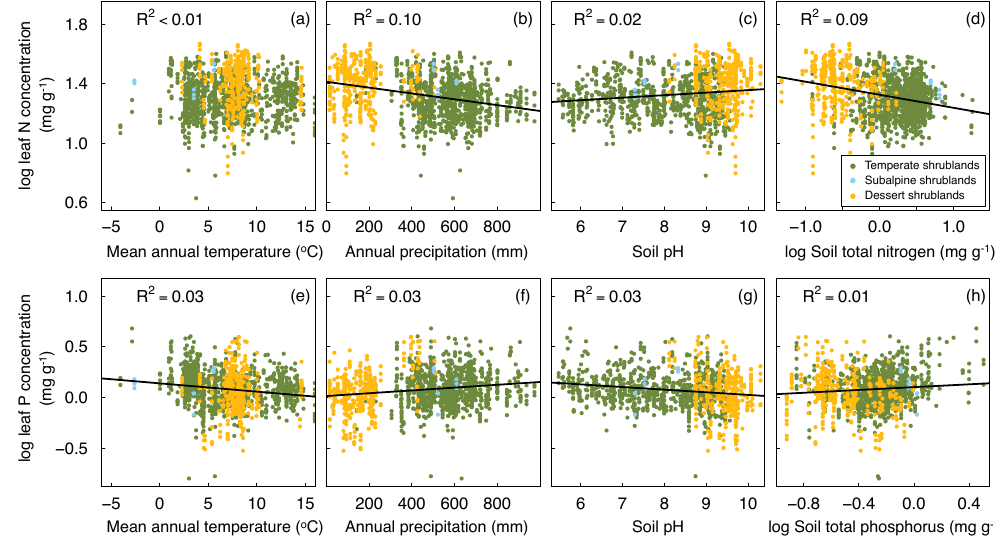
Figure 2. Changes of log-transformed leaf nitrogen and phosphorus concentrations in relation to climate (mean annual temperature and annual precipitation) and soil nutrient (soil pH and soil total nitrogen and phosphorus concentrations) for shrubs in northern China. Green, yellow, and blue dots represent samples from temperate, subalpine, and desert shrublands, respectively. Solid lines represent regressions significant at p< 0 . 001.